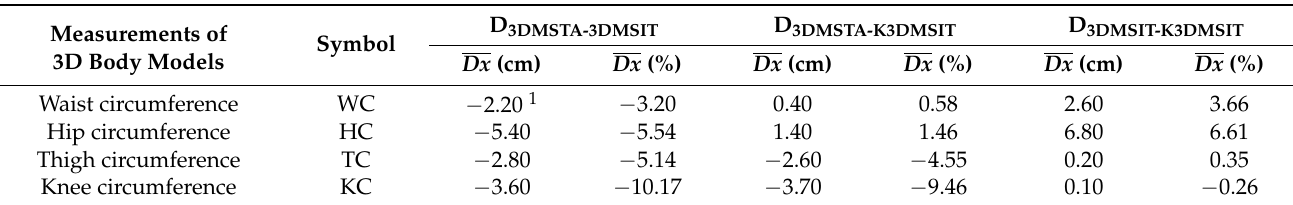
Table 9. Differences between mean values of the 3DMSTA and 3DMSIT, 3DMSTA and K3DMSIT and between 3DMSIT and